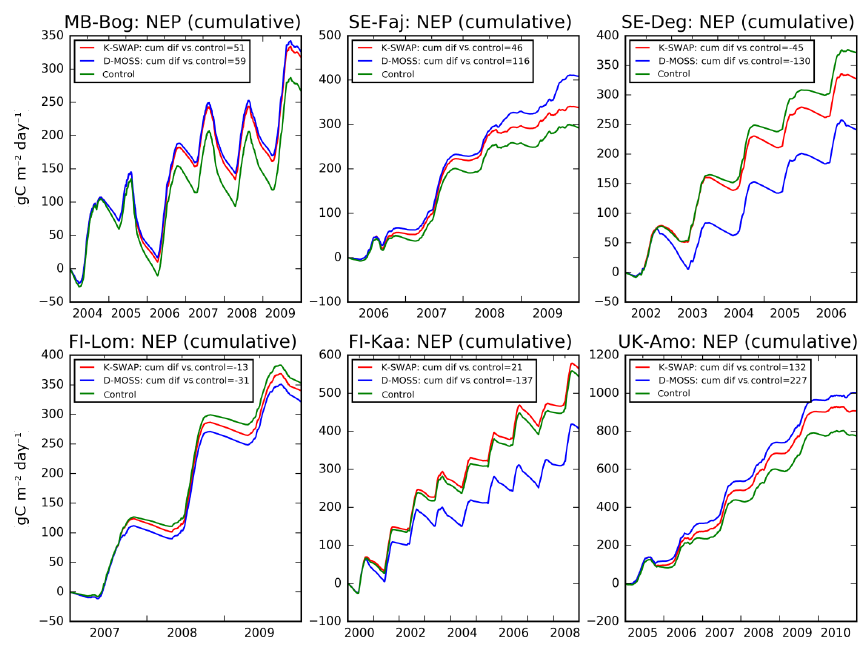
Figure 19. Cumulative NEP for bog and fen sites over the test periods, for the control runs and the two sensitivity tests K-SWAP and D-MOSS.